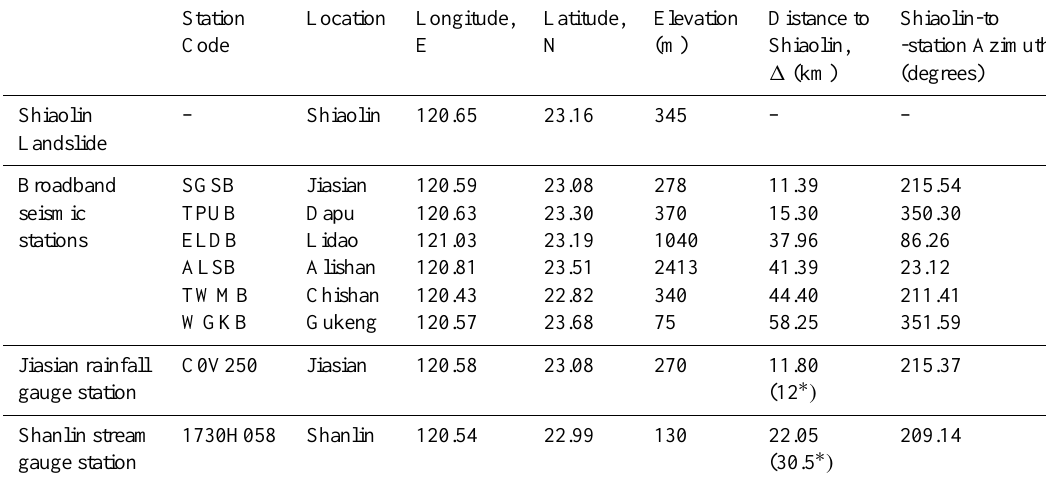
Table 1. Station information and the distances to Shiaolin.